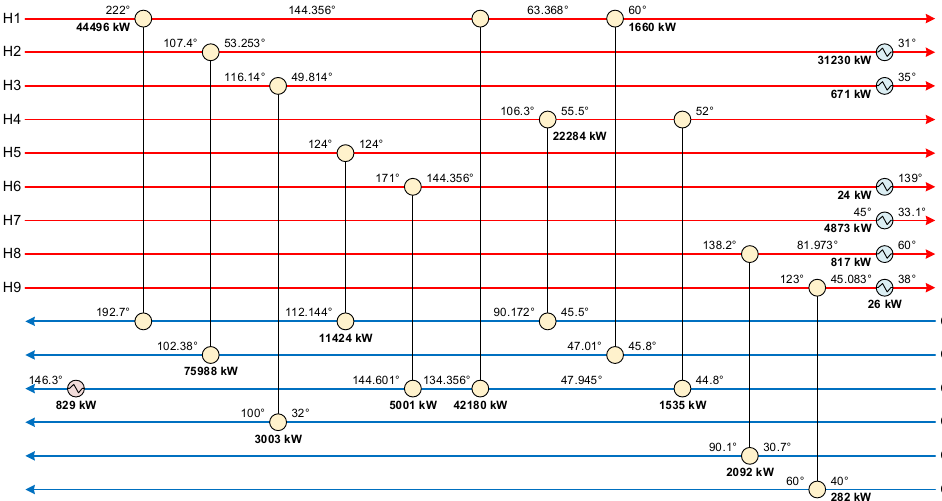
Figure 6. Alternative HEN of the EG process.